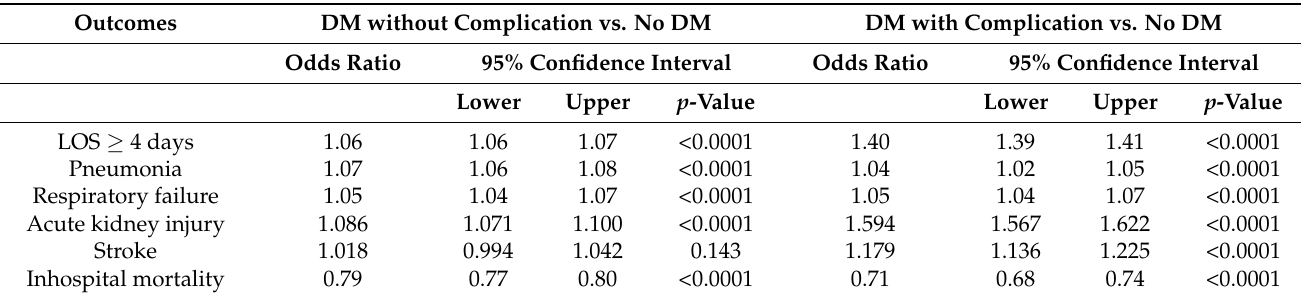
Table 3. Multivariate logistic regression analysis showing the adjusted odds ratios predicting the specific outcomes for chronic obstructive pulmonary disease hospitalizations.